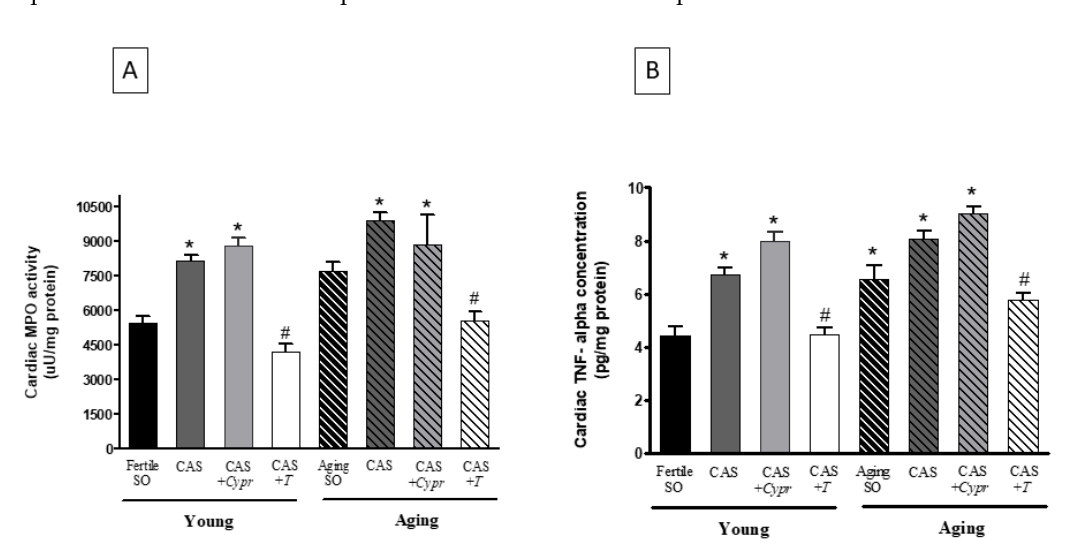
Figure 4. (A ) The e ff ects of aging, surgical castration, and testosterone replacement therapy on the cardiac myeloperoxidase enzyme activity (MPO; expressed as uU / mg protein). The results are shown as the means ± S.E.M. n = 7–10. ( B ) The e ff ects of aging, surgical castration, and testosterone replacement therapy on the cardiac tumor necrosis factor-alpha concentration (TNF- α ; expressed as pg / mg protein). The results are shown as the means ± S.E.M. n = 7–9 * p < 0.05: Statistical significance relative to the Young / SO fertile group, # p < 0.05: Statistical significance between age-matched CAS and CAS + T groups, CAS = surgical castration, T = testosterone replacement therapy, Cypr = cyproterone acetate treatment, and SO = sham operation.